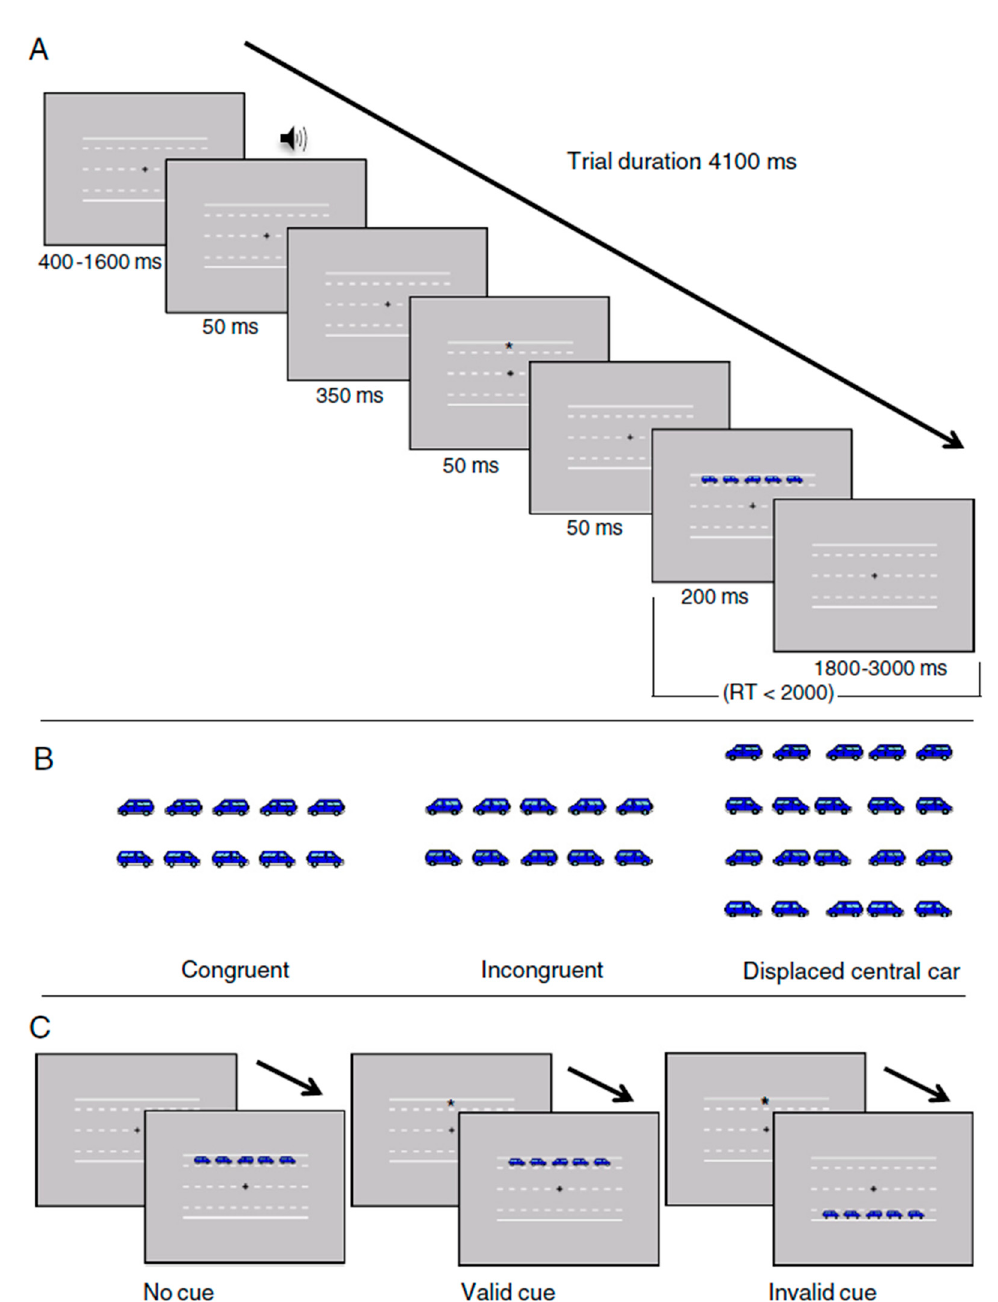
Figure 1. Procedure and stimuli of the ANTI-V. ( A ) Schematic representation of the procedure. ( B ) The target stimuli. ( C ) The visual cue conditions.